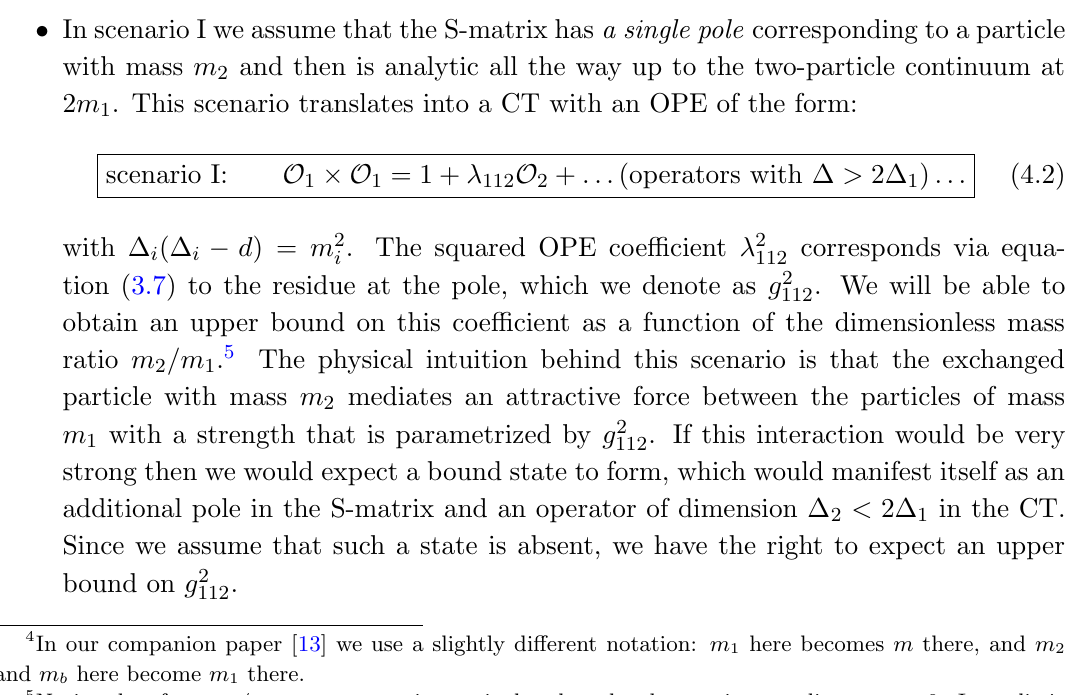
of an operator O with dimension such that (cid:1) 1 point function to a numerical analysis in two following scenarios, displayed in (cid:12)gure 4.